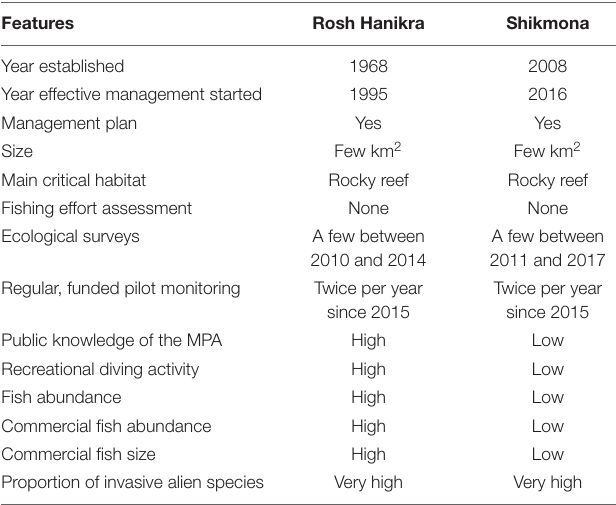
TABLE 2 | Main institutional and ecological features in two small MPAs (now both marine reserves) in northern Israel.